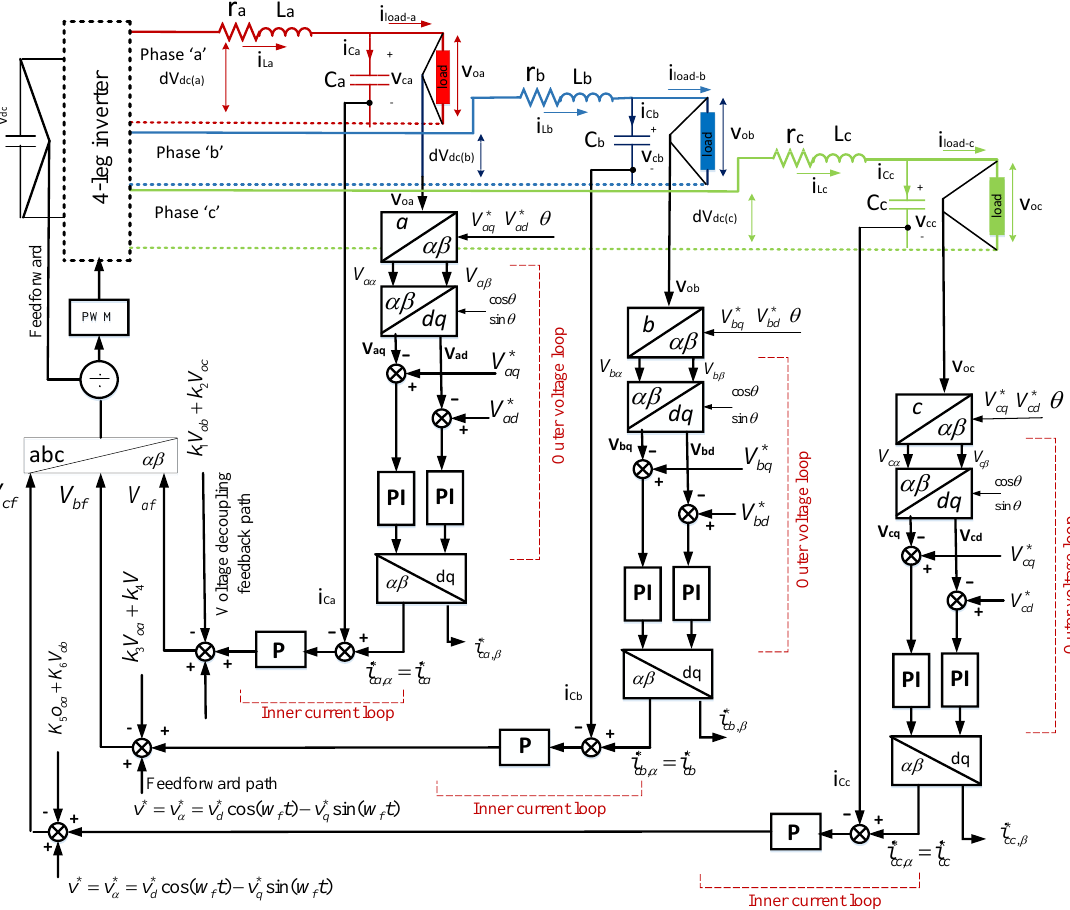
Figure 6. Proposed multi-loop voltage and current control strategy.